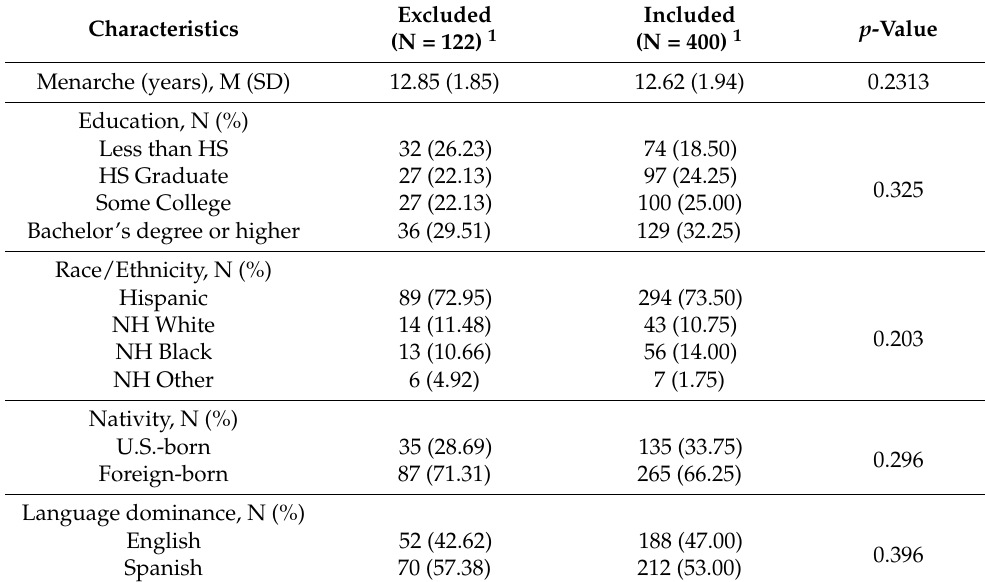
Table A1. Sample eligibility comparisons.